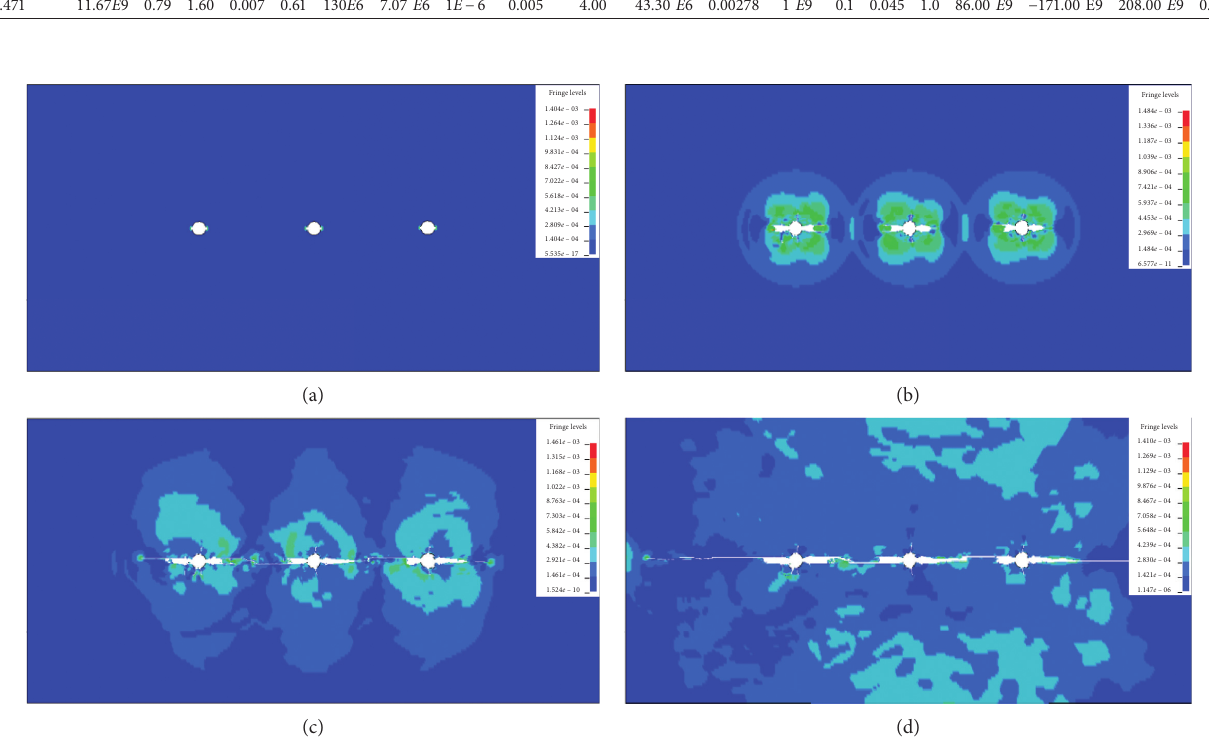
Figure 7: Effective stress distribution of three-hole directional fracture blasting. (a) t � 5us; (b) t � 60.5us; (c) t � 164us; and (d) t � 479us.